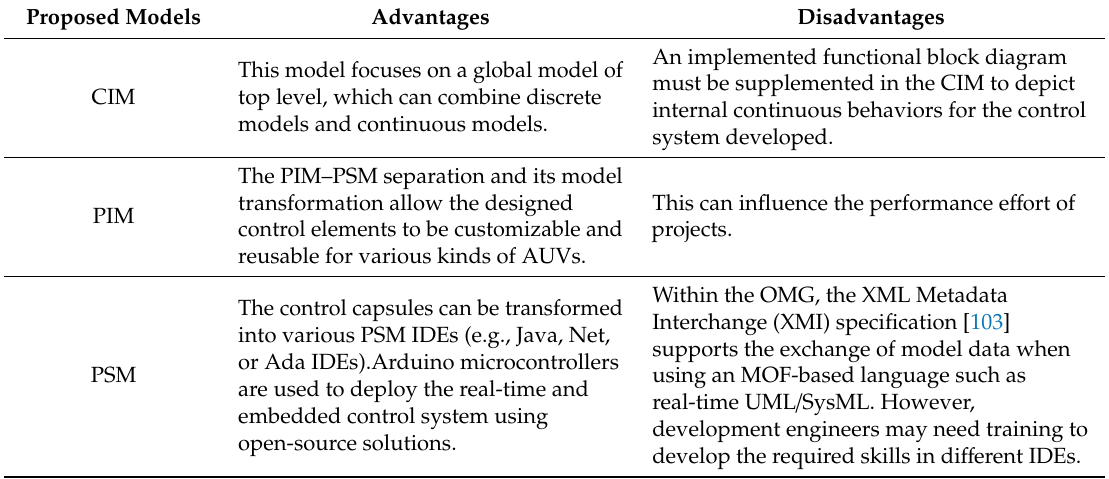
Table 5. Assessment of the torpedo-shaped AUV control application of model-based systems engineering (MBSE) methodology combined with the model-driven architecture (MDA). CIM, computation-independent model; PIM, platform-independent model; PSM, platform-specific model; IDE, implementation development environments; OMG, Object Management Group; XML,